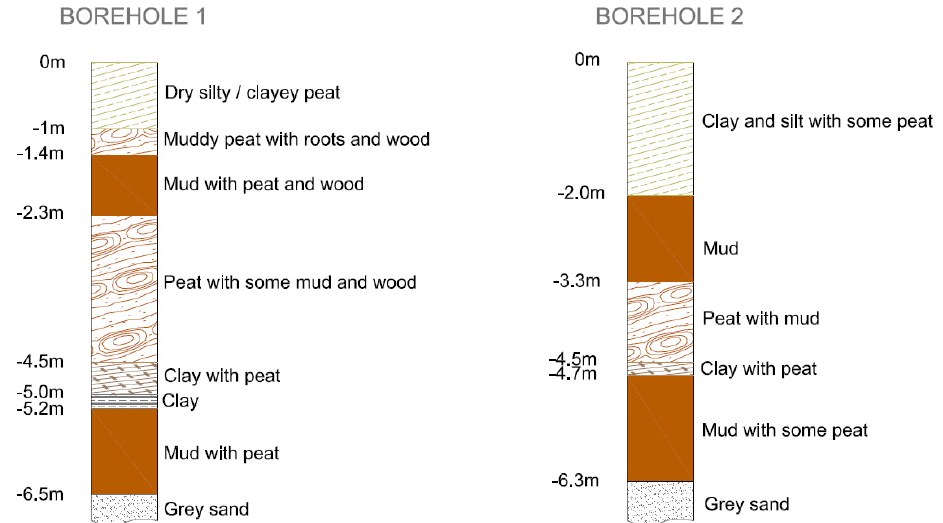
Fig. 3 Measured groundwater levels in three piezometers (pressure transducer PT 2 measures confined levels and PT 3 and PT 4 measure phreatic levels. PT 1 had to be discarded).